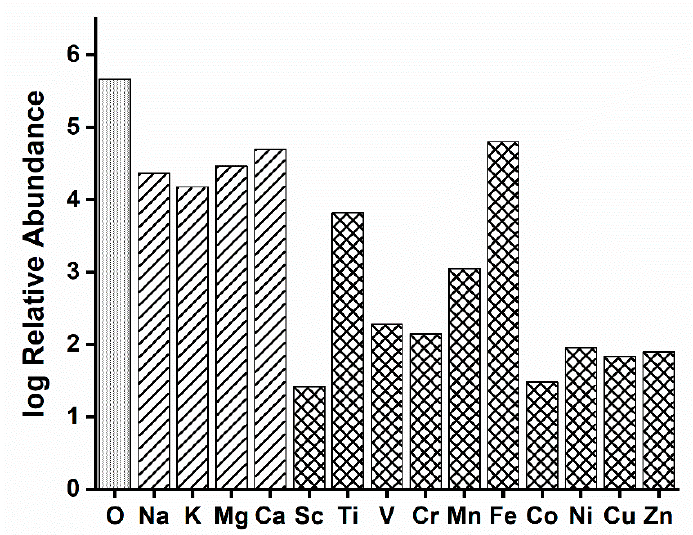
Figure 2. The relative abundance (ppm) on a log scale of oxygen (small dashes), biologically relevant main group metals (diagonal lines), and the first-row transition metals (cross hatching) in the Earth’s crust on a log scale. This figure was redrawn and modified from Reference [12].